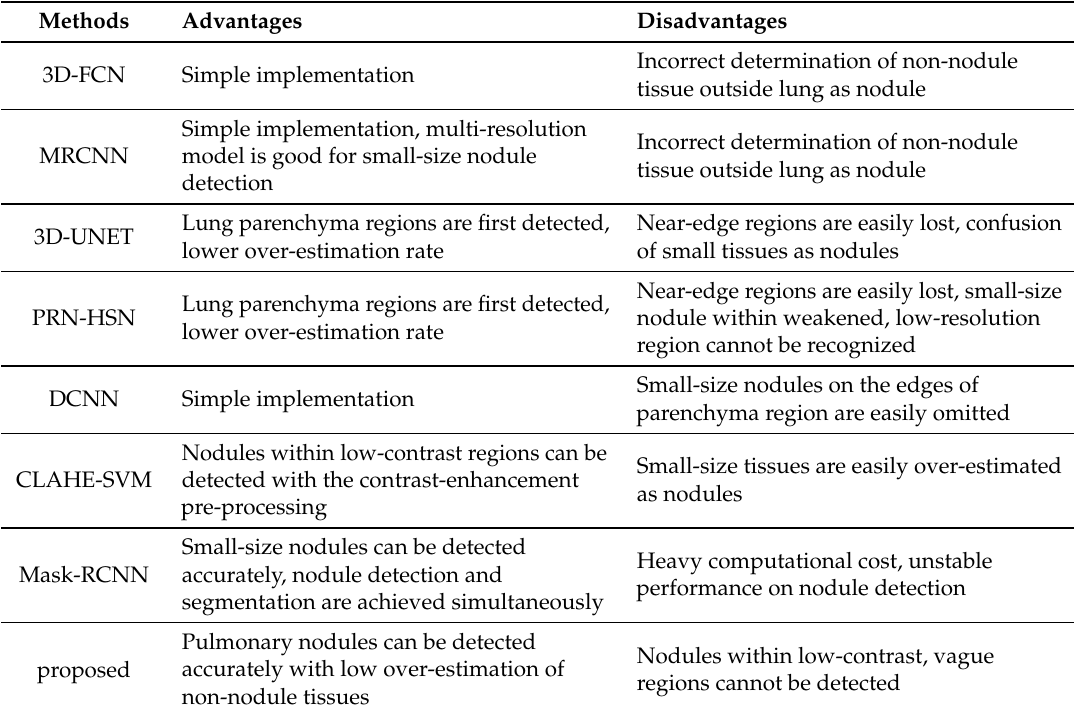
Table 1. Advantages and disadvantages of the comparison